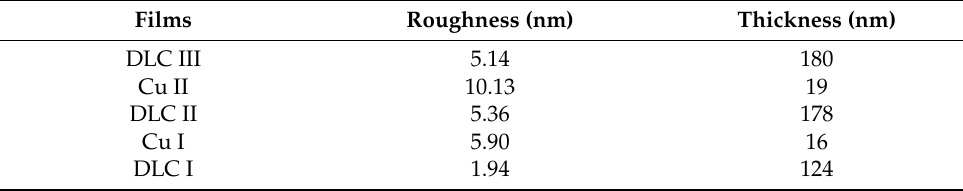
Table 3. Roughness and thickness of the films for the samples in group